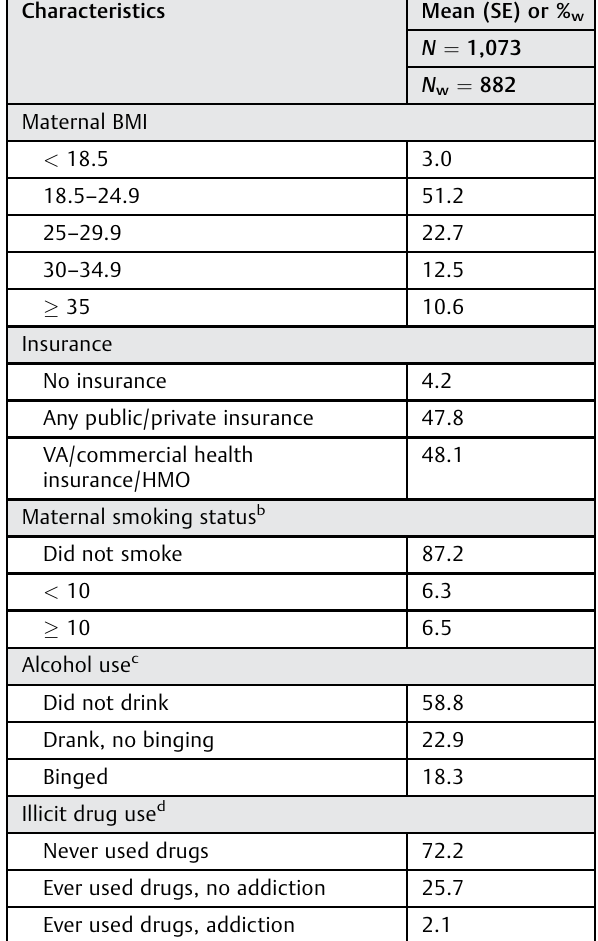
Table 1 Descriptive characteristics of study population